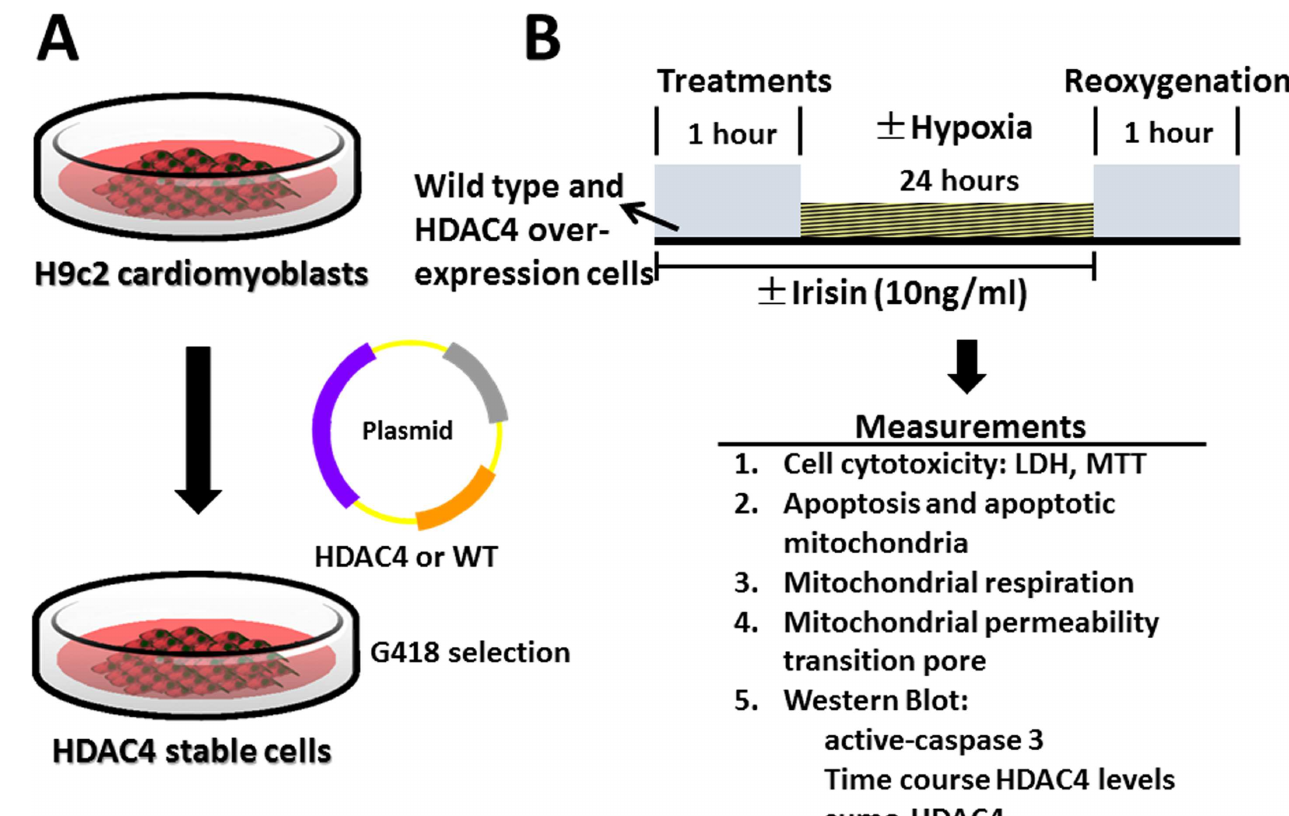
Fig 1. The experimental protocol. (A) Generation of HDAC4 overexpression cell. (B) Hypoxia/reoxygenation experimental protocolin H9C2 cardiomyoblasts and HDAC4 overexpression cells.